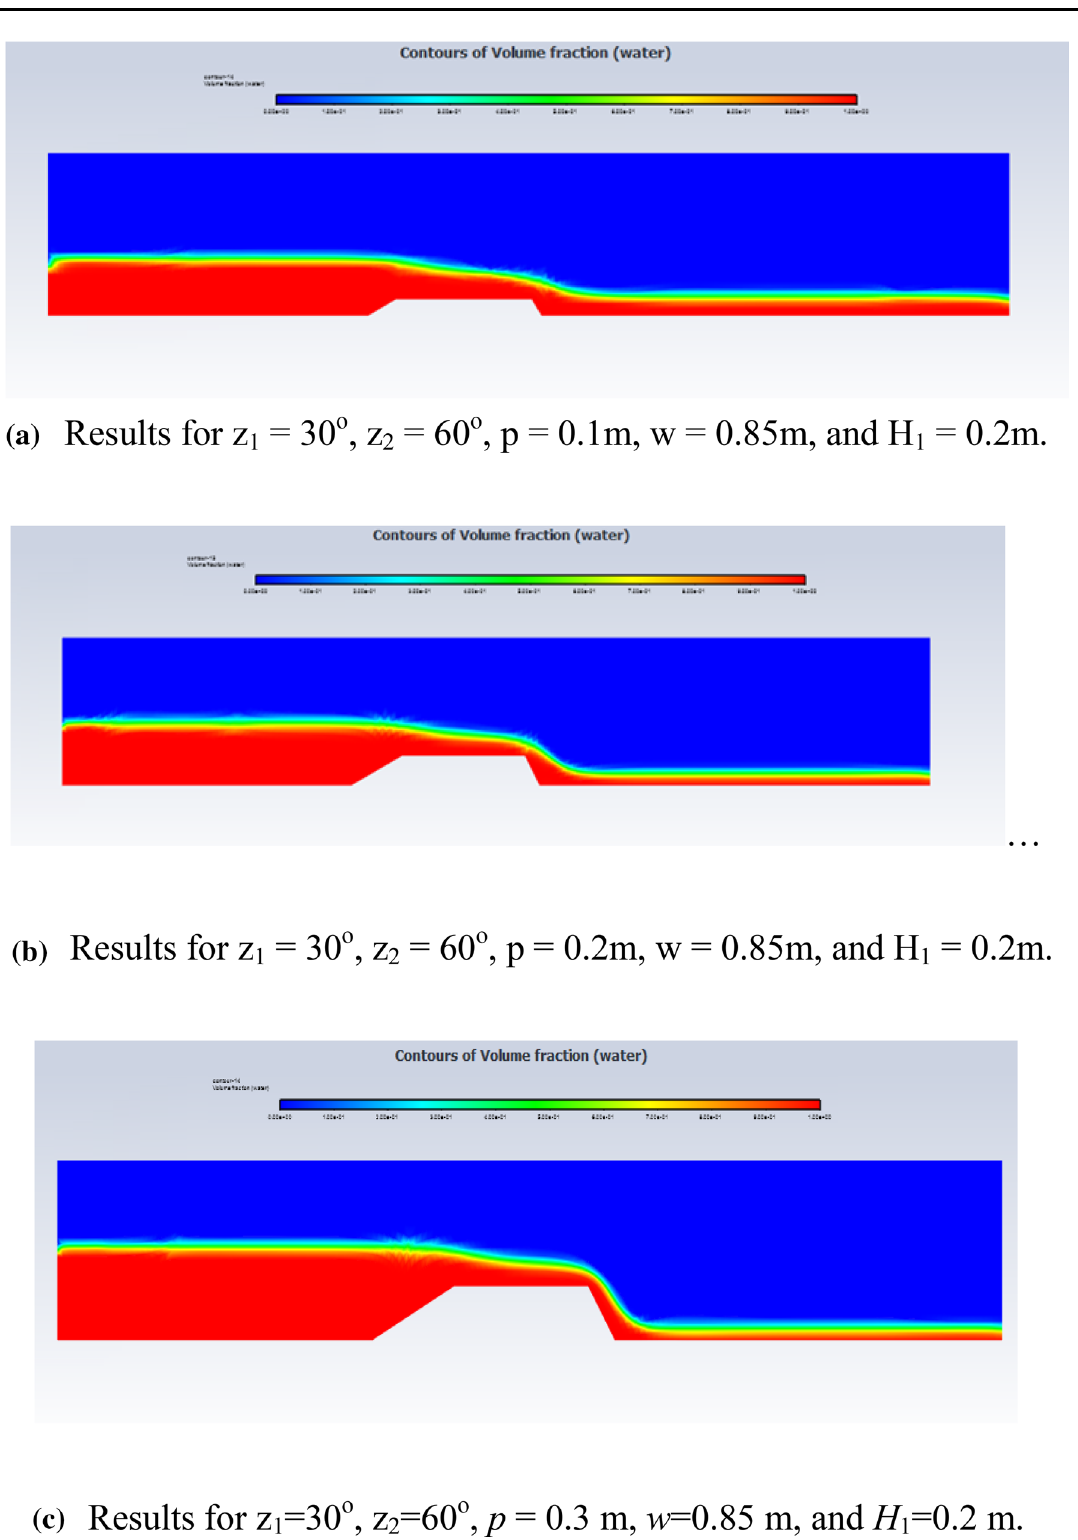
Fig. 3 Water level profiles for broad-crested weirs with upstream and downstream sloped faces and for different weir